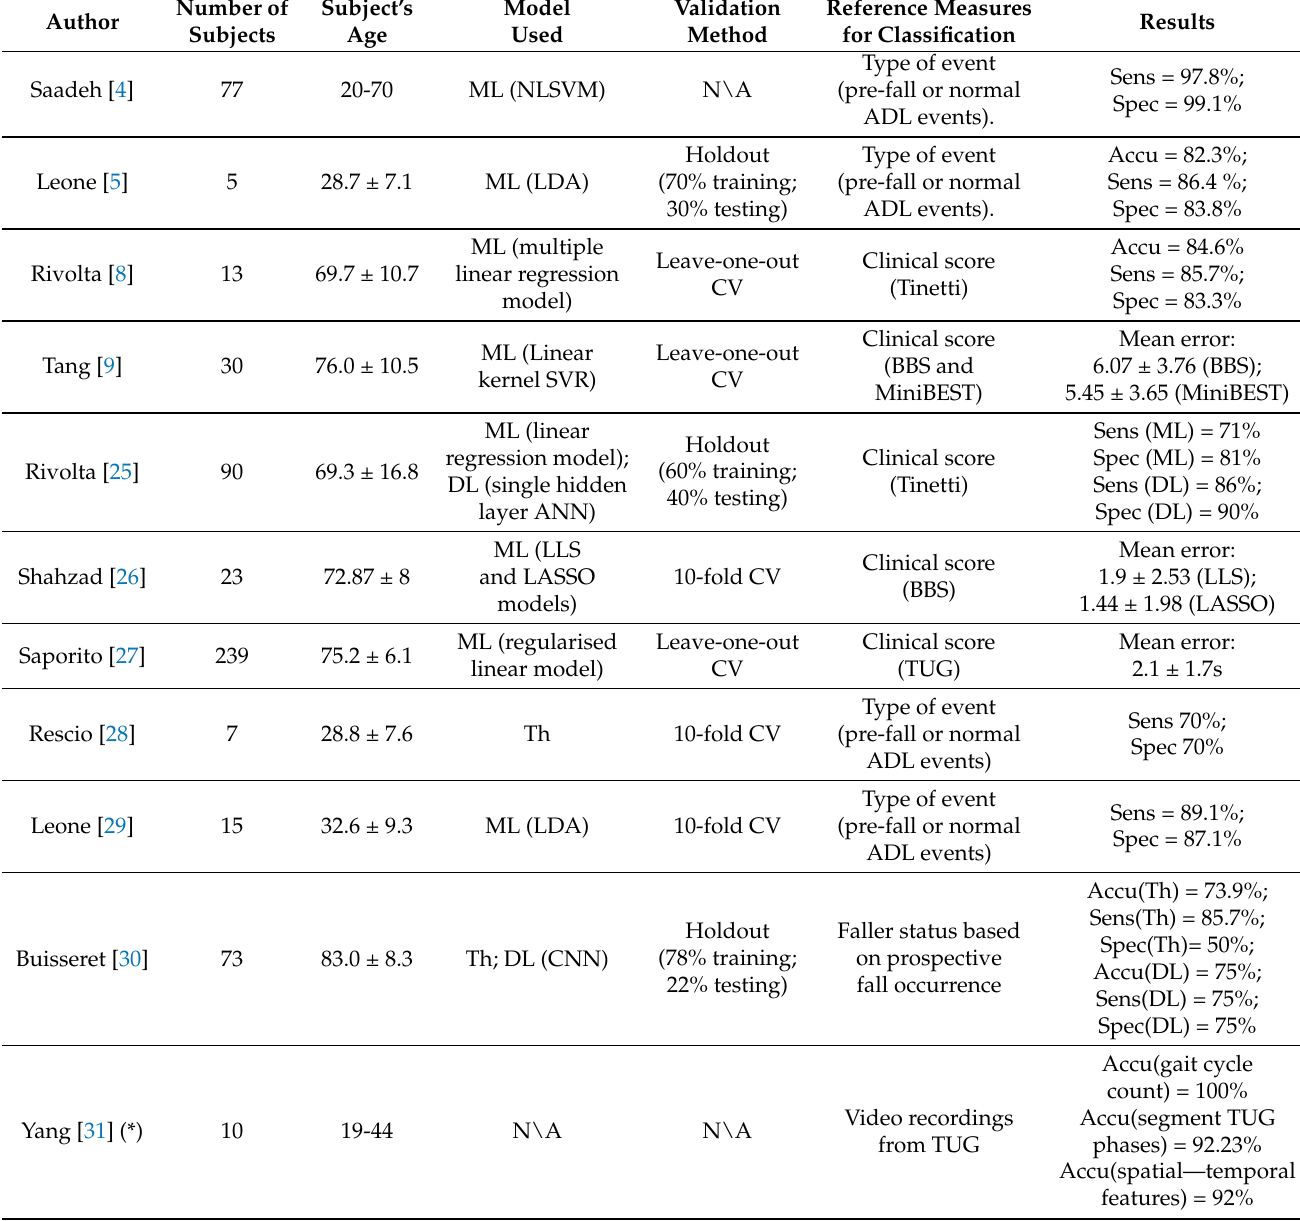
Table 2. Validation characteristics adopted by the 11 selected articles, where: ML = machine learning, Th = threshold-based, Accu = accuracy, Sens = sensitivity, Spec = specificity, CV = cross-validation, NLSVM = NonLinear Support Vector Machine classifier, LDA = Linear Discriminant Analysis classifier, SVR = Support Vector Regression, ANN = Artificial Neural Networks, LLS = Linear Least Square Regression, LASSO = Least Absolute Shrinkage and Selection Operator regression, and CNN = Convolutional Neural